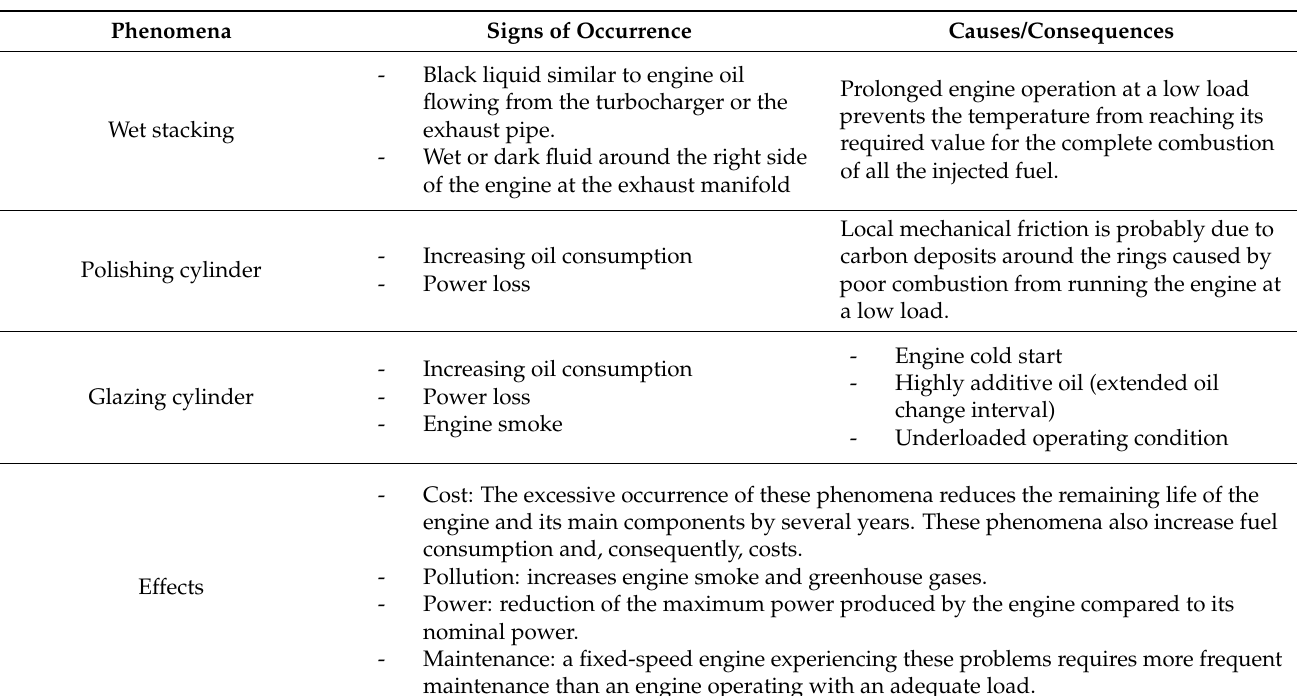
Table 1. Effects of fixed-speed diesel–electric generator light load running